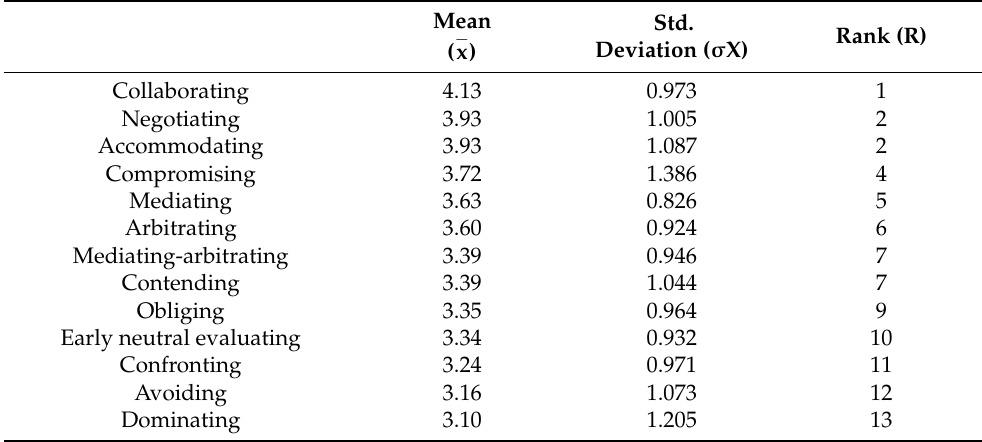
Table 1. Methods of resolving conflict among construction